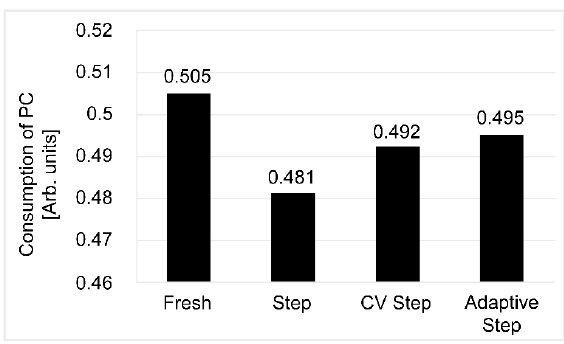
Figure 9. Standardized residual electrolyte propylene carbonate components of the 3.3 Ah